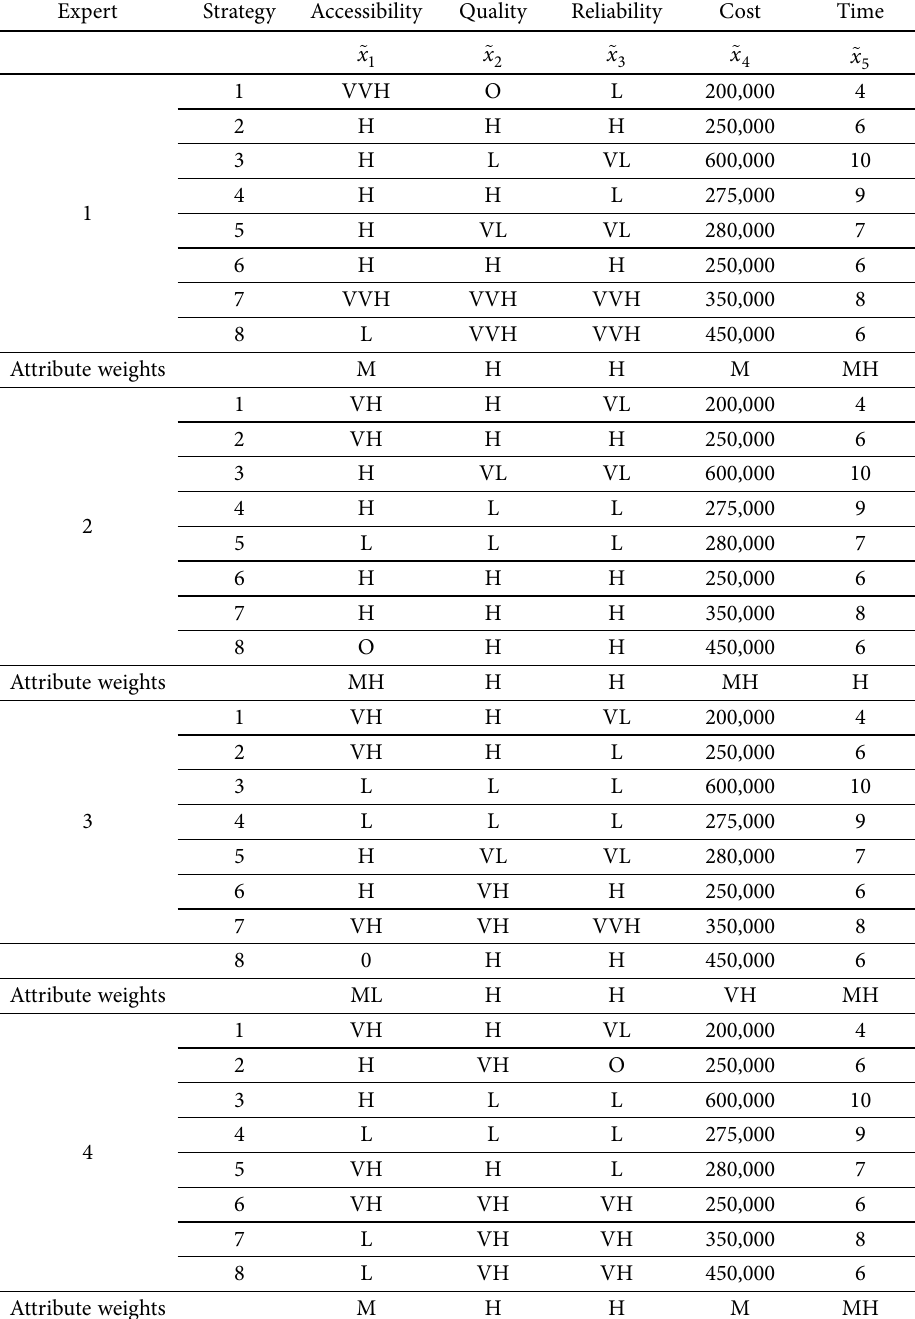
Table 5. Individual decision matrices of experts